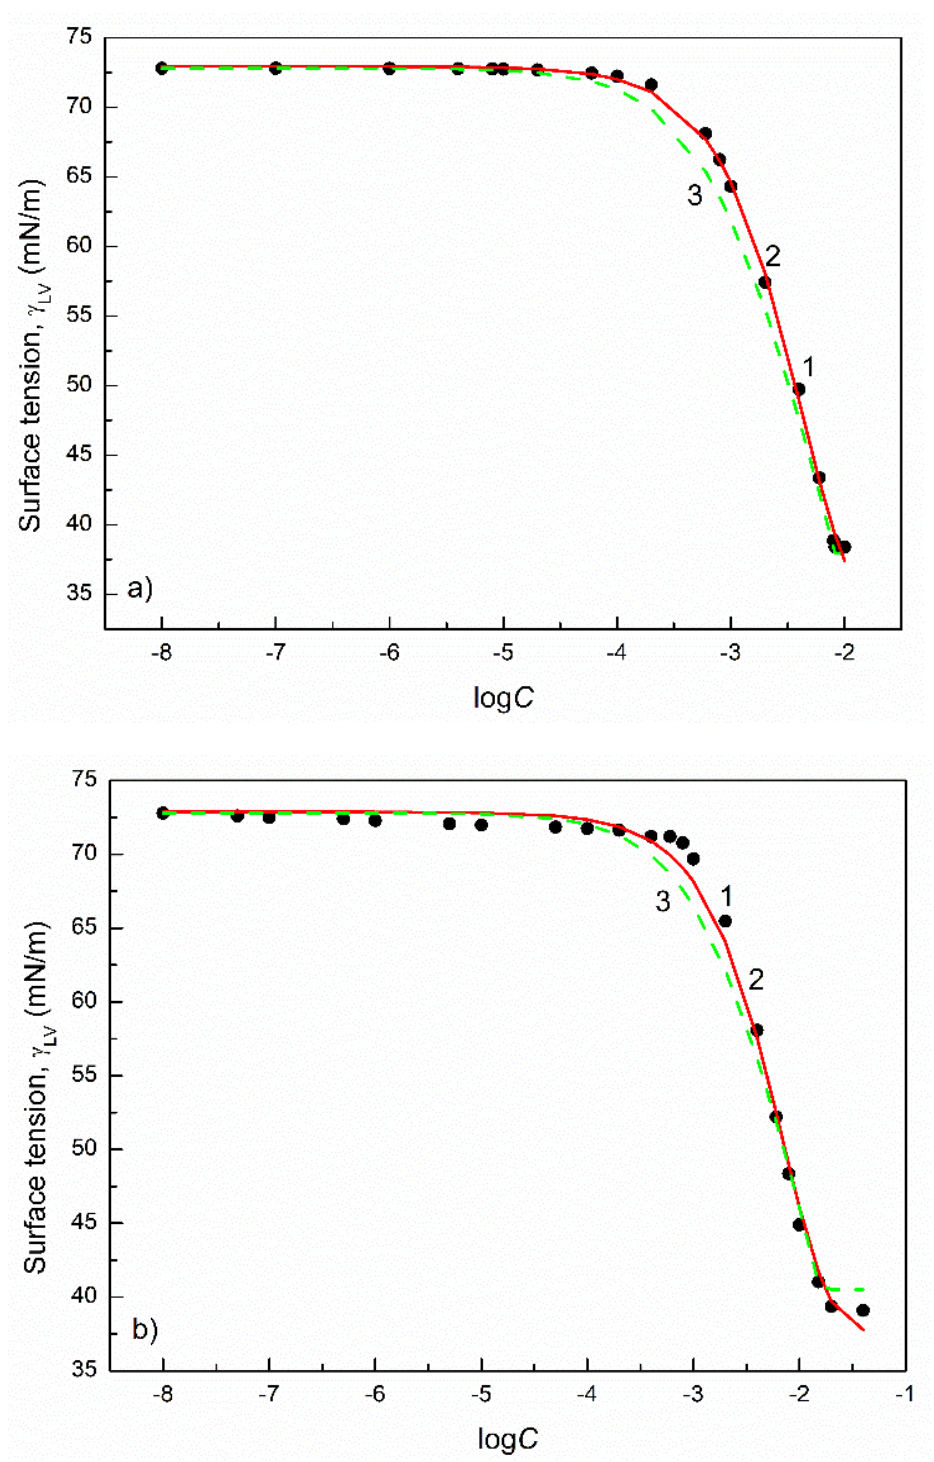
Figure 2. A plot of the surface tension ( 𝛾 𝐿𝑉 ) of the aqueous solutions of SDDS ( a ) and SDS ( b ) vs. the logarithm of their concentration ( 𝑙𝑜𝑔𝐶 ). Points 1 correspond to the measured values [28,32], curves 2 and 3 correspond to the values calculated from the exponential function of the second order (Equation (2)) and Szyszkowski equation (Equation (3)), respectively.